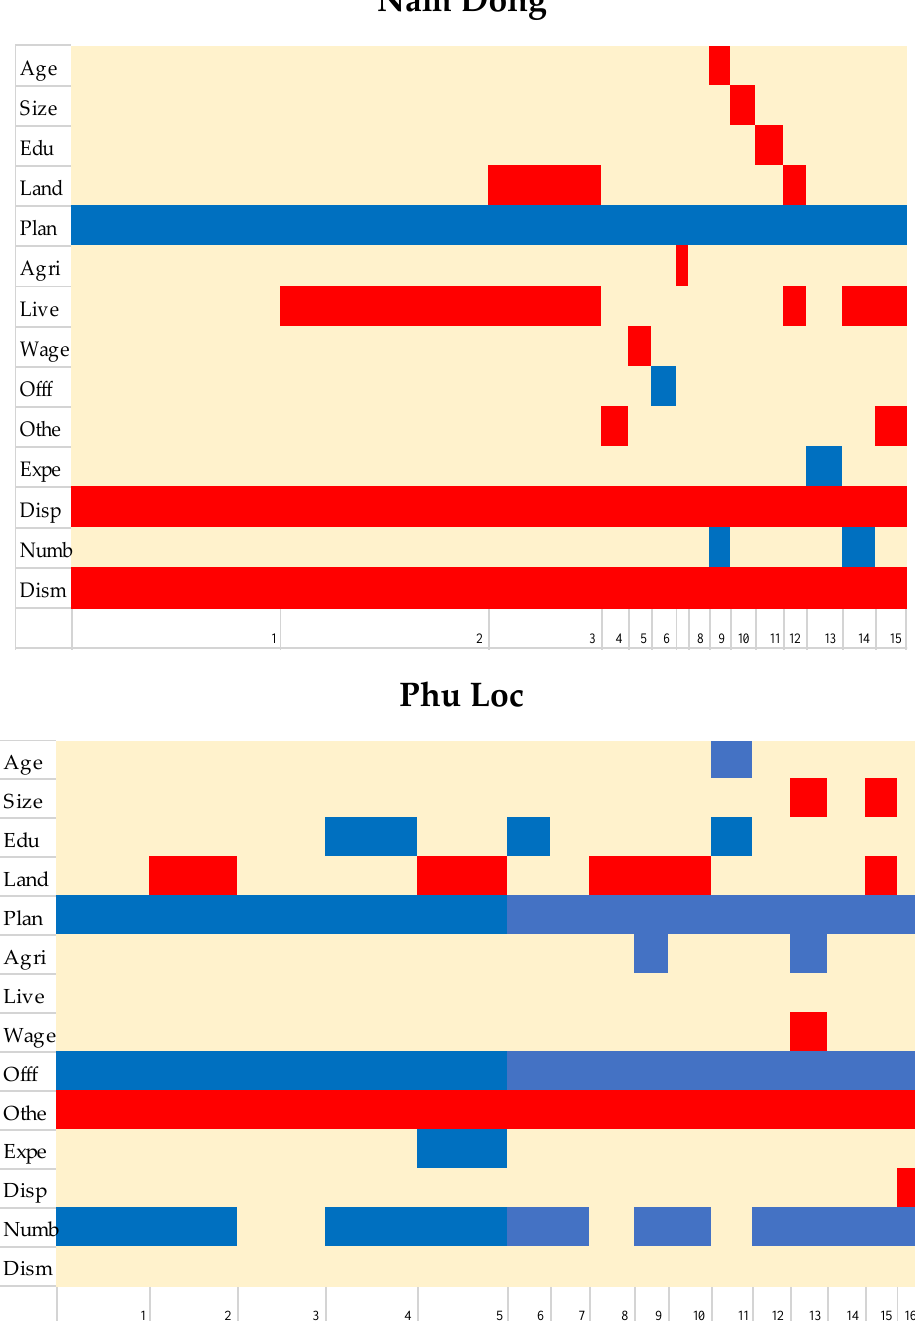
Figure 5. Models of socio-economic and contextual attributes impacting Acacia hybrid timber income of producers, selected by BMA analysis in Nam Dong and Phu Loc districts. Source: Field research (2018, 2019). Note: Blue color referred to positive relation, red color referred to negative relation. The socio-economic and contextual attributes used in the regression model are presented in Table S2. Other significant predictor variables in Nam Dong were distance to processing company ( p = 0.000) and to plantation area ( p = 0.000). A 1 Sd increase in distance to companies where Acacia hybrid logs were sold led to a 10.5-unit Sd decrease in this timber income. Similarly, a 1 Sd increase in distance to plantation area caused a 1.5 Sd decrease in Acacia hybrid timber income. However, these factors only explained less than 3% of the Acacia hybrid timber income change in Phu Loc district (Table